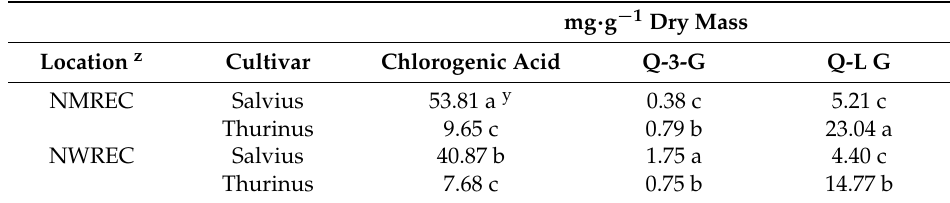
y Values in the same column for the same interaction (location and cultivar) followed by the same letter are not significantly different at p ≤ 0.05 according to the Tukey’s Honest Significant Difference test. z The North Mississippi Research and Extension Center (NMREC) in the Mississippi State University, Verona, MS, USA and the Northwest Washington Research and Extension Center (NWREC) in the Washington State University, Mount Vernon, WA, Table 2. The interaction of growing locations and lettuce cultivars on the concentrations of phenolic secondary metabolites quercetin-3-glucoside (Q-3-G) and quercetin/luteolin glucuronide (QL-G) in green and red romaine lettuce cultivars.